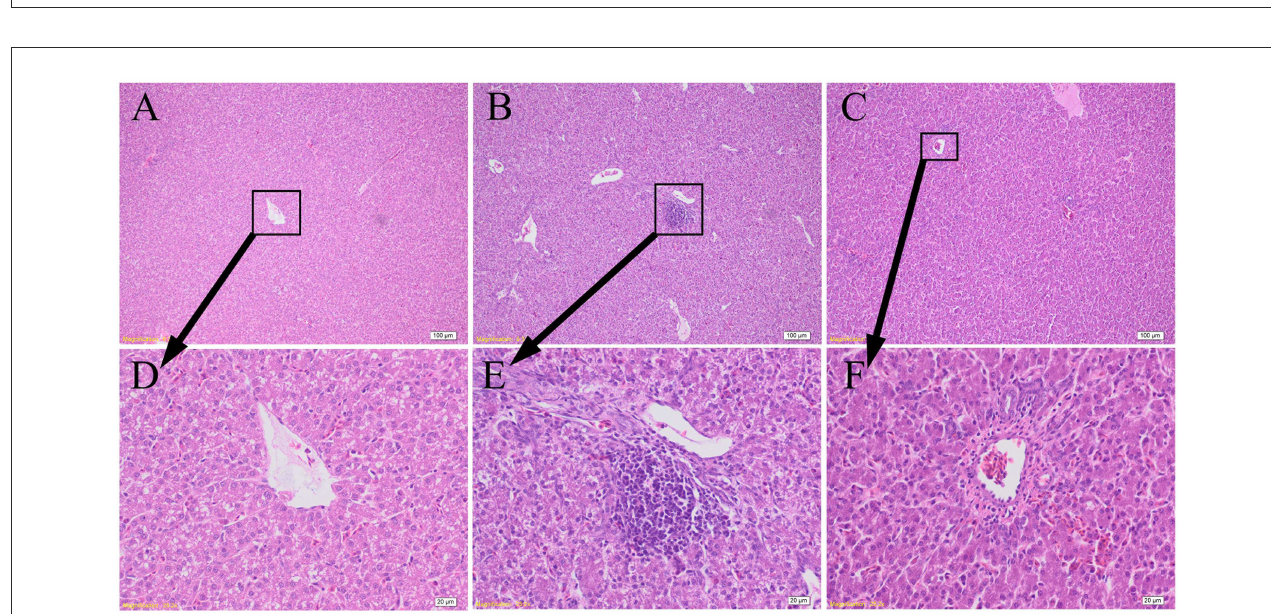
FIGURE4 Effects of dietary Galla Chinensis tannin (GCT) supplementation on hepatic histopathology. (A–C) Hematoxylin and eosin photomicrographs of CON, LPS, and LPS + GCT obtained at 100 × magnification, respectively; (D–F) Hematoxylin and eosin photomicrographs of CON, LPS, and LPS + GCT obtained at 400 × magnification, respectively. CON, fed on a basal diet and intraperitoneally injected with saline solution; LPS, fed on a basal diet and intraperitoneally injected with LPS; LPS + GCT, fed on a basal diet supplemented with 300 mg/kg GCT and intraperitoneally injected with LPS.